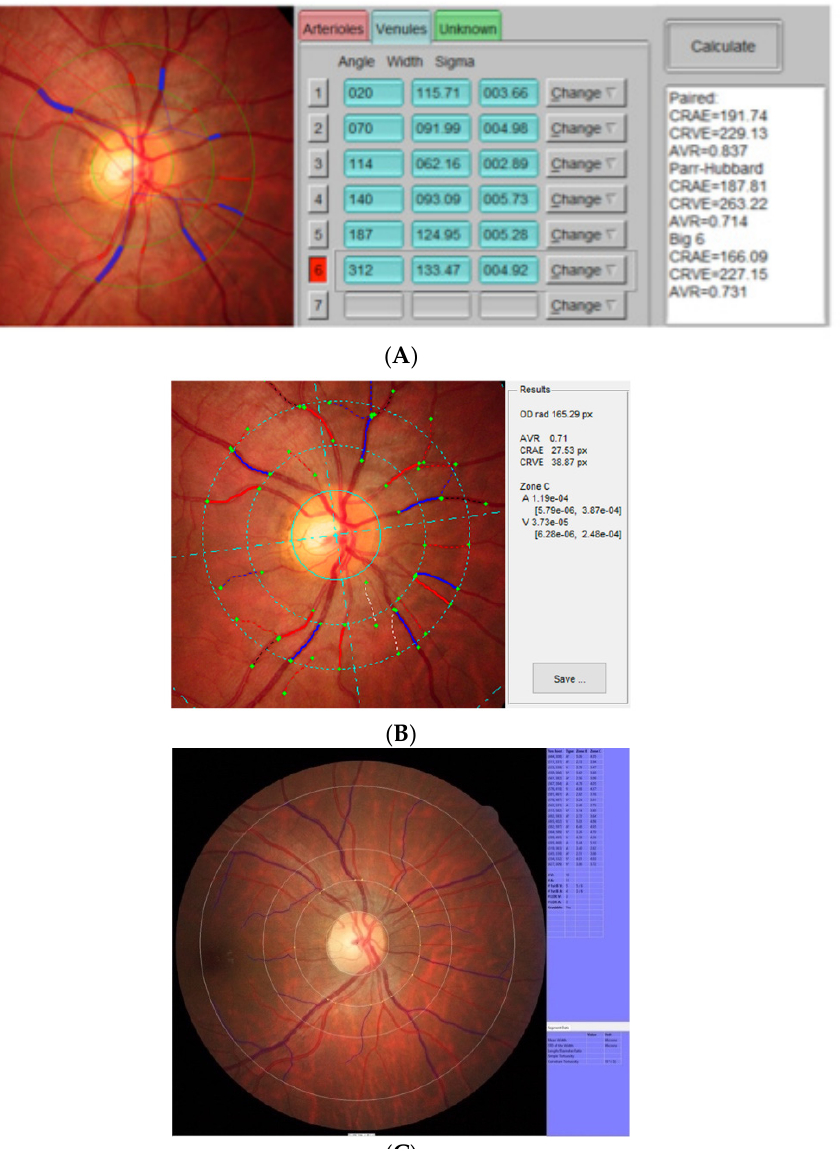
Figure 1. Presentation of the interface of each software. ( A ) VAMPIRE software interface, ( B ) IVAN interface, and ( C ) SIVA interface.